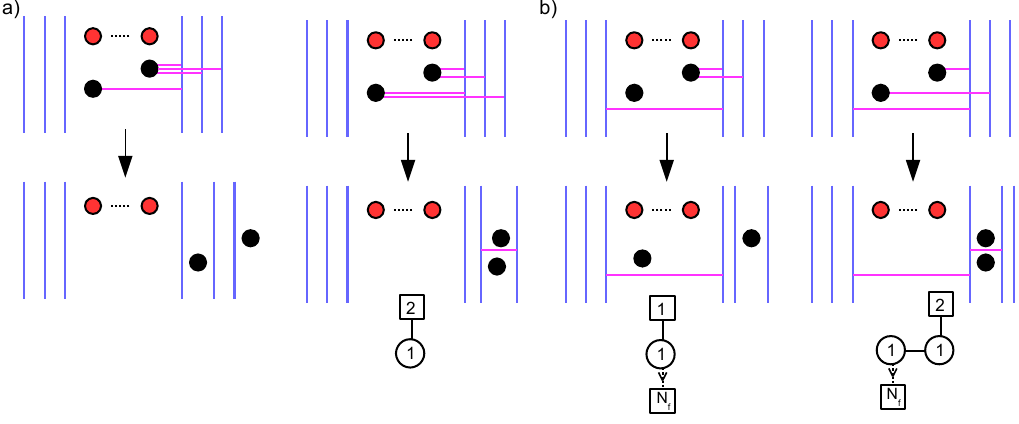
Figure 6 . Brane patterns for three-point correlators in the U(2) SQCD theory and associated SMM. a) h V 2 V i , b) h V V V i (1 ; 1) (1 ; 0) (1 ; 1) (0 ; (cid:0) 1) (1 ; 0)